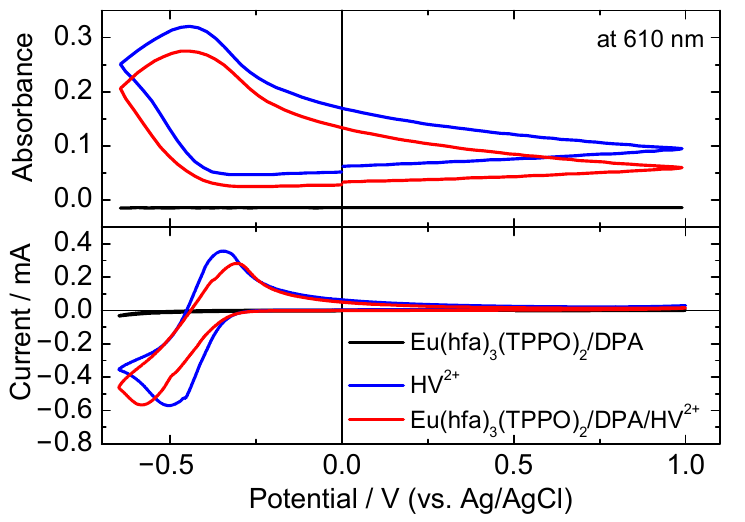
−−−−− Figure 2. CVs of the electrolyte solutions in three-electrode cell (black line: Eu(hfa) 3 (TPPO) 2 /DPA, blue line: HV 2+ , red line: Eu(hfa) 3 (TPPO) 2 /DPA/HV 2+